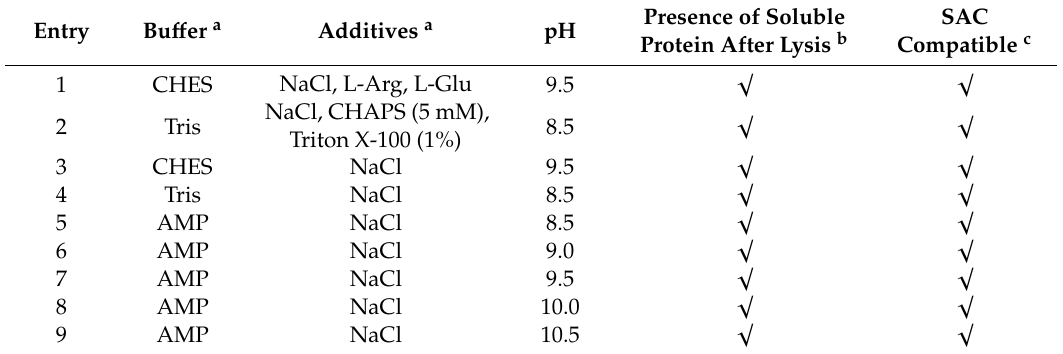
Table 2. Bu ff er compositions investigated during cell lysis and SAC purification of TF-Sil α -Strep.